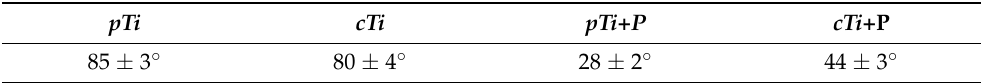
Table 1. WCA values before and after plasma treatment.